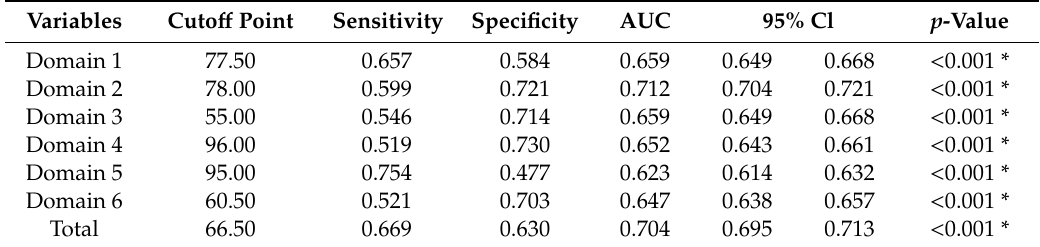
Table A1. Predictive accuracy of WHODAS 2.0 for institutionalization among dementia